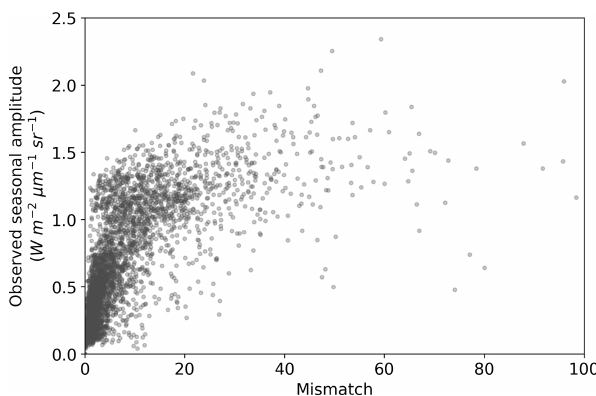
Figure 6. Seasonal amplitude of observed SIF versus the model- observed mismatch for the SIF optimized (SIF post ) model. Mis- match is defined as the squared residual normalized by the ob- servational uncertainty (expressed as variances). A positive curvi- linear relationship exists such that spatiotemporal points with a large model-observed mismatch generally also exhibit a large ob- served seasonal